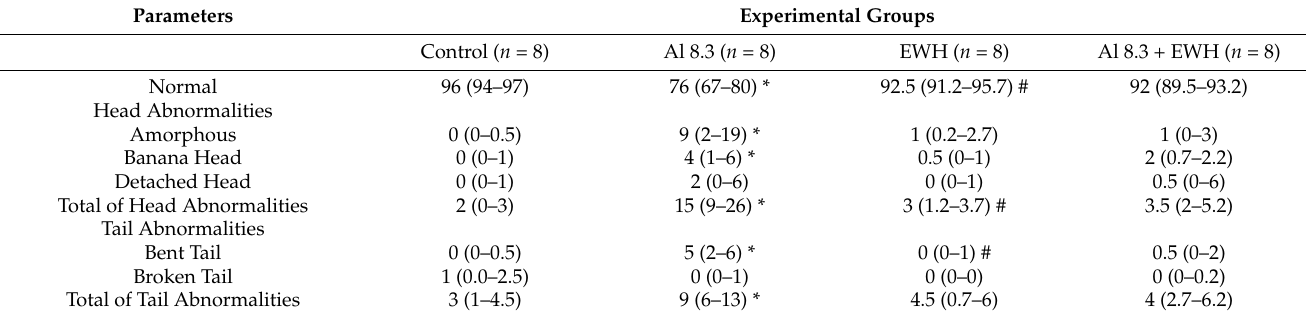
Table 5. Effect of EWH on sperm morphology of rats exposed to AlCl 3 at 8.3 mg/kg for 60 days.